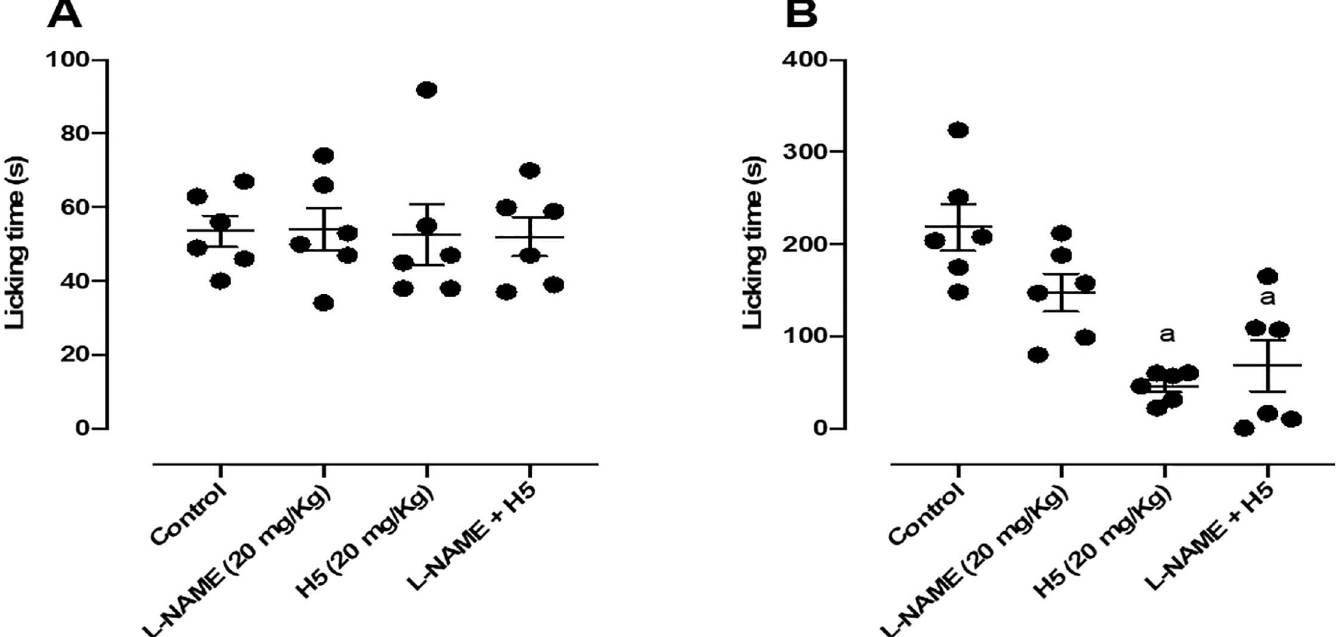
Fig 6. Effect of L -NAME (20 mg/kg, i.p.), H5 (20 mg/kg, p.o.), L -NAME + H5, in the first (A) and second (B) phases of the formalin-induced nociception test in mice (n = 6, per group). Values are expressed as the mean ± S.E.M., where a indicates p < 0.05 in comparison with control group, according to ANOVA, followed by Tukey’s post-test.